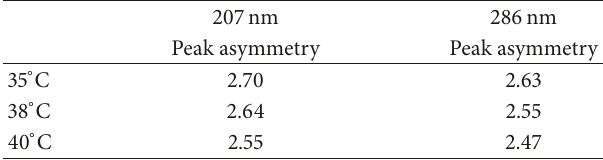
Table 2: Peak asymmetry for each temperature and